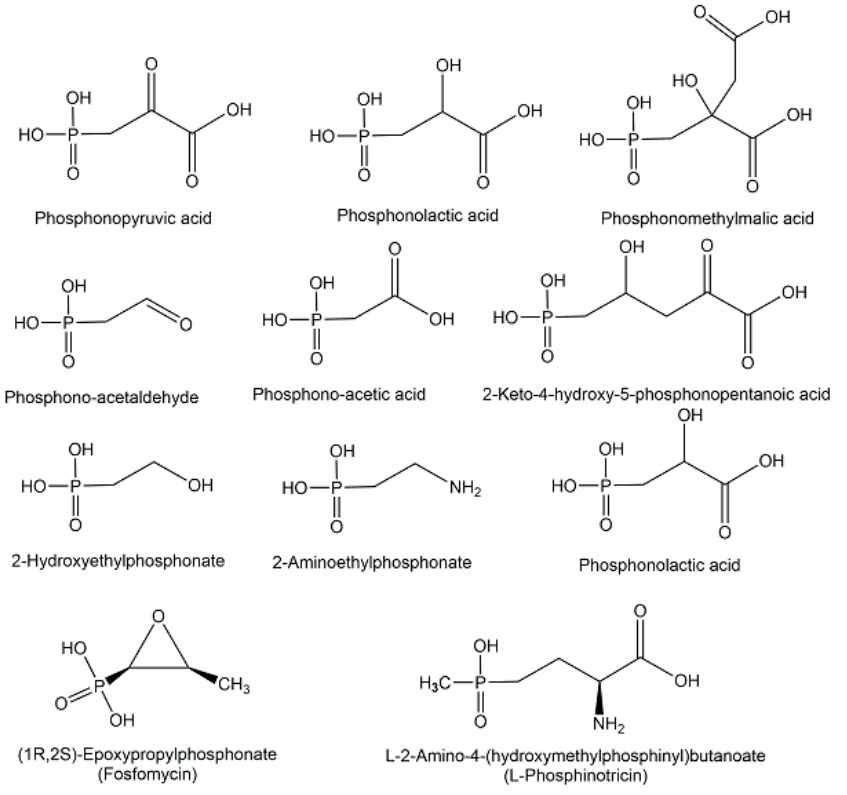
Figure 11. Selected microbial phosphometabolites containing phosphorus-carbon bonds.